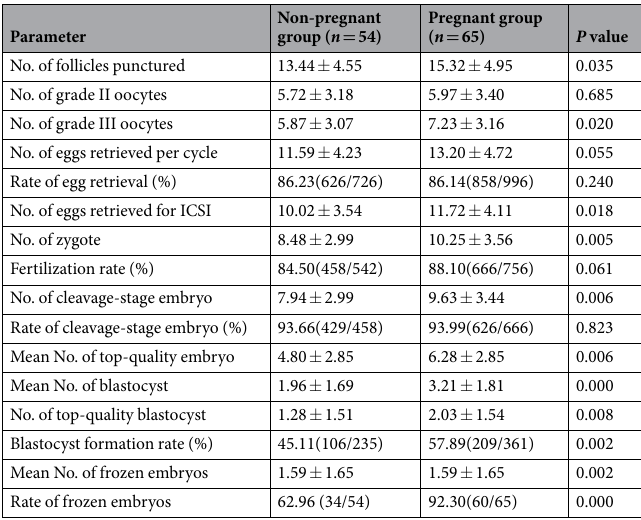
Table 2. Comparison of clinical outcomes between pregnant and non-pregnant women after